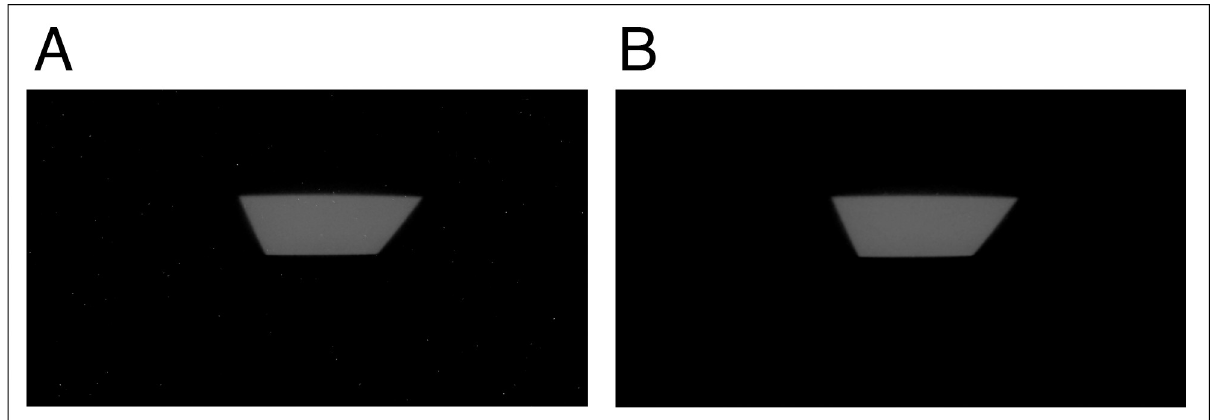
Fig 4. FBNR technique: (A) Original two-dimensional (2D) scintillation distribution, (B) 2D scintillation distribution after application of the FBNR technique. https://doi.org/10.1371/journal.pone.0246742.g004 PLOS ONE | https://doi.org/10.1371/journal.pone.0246742 February 12,